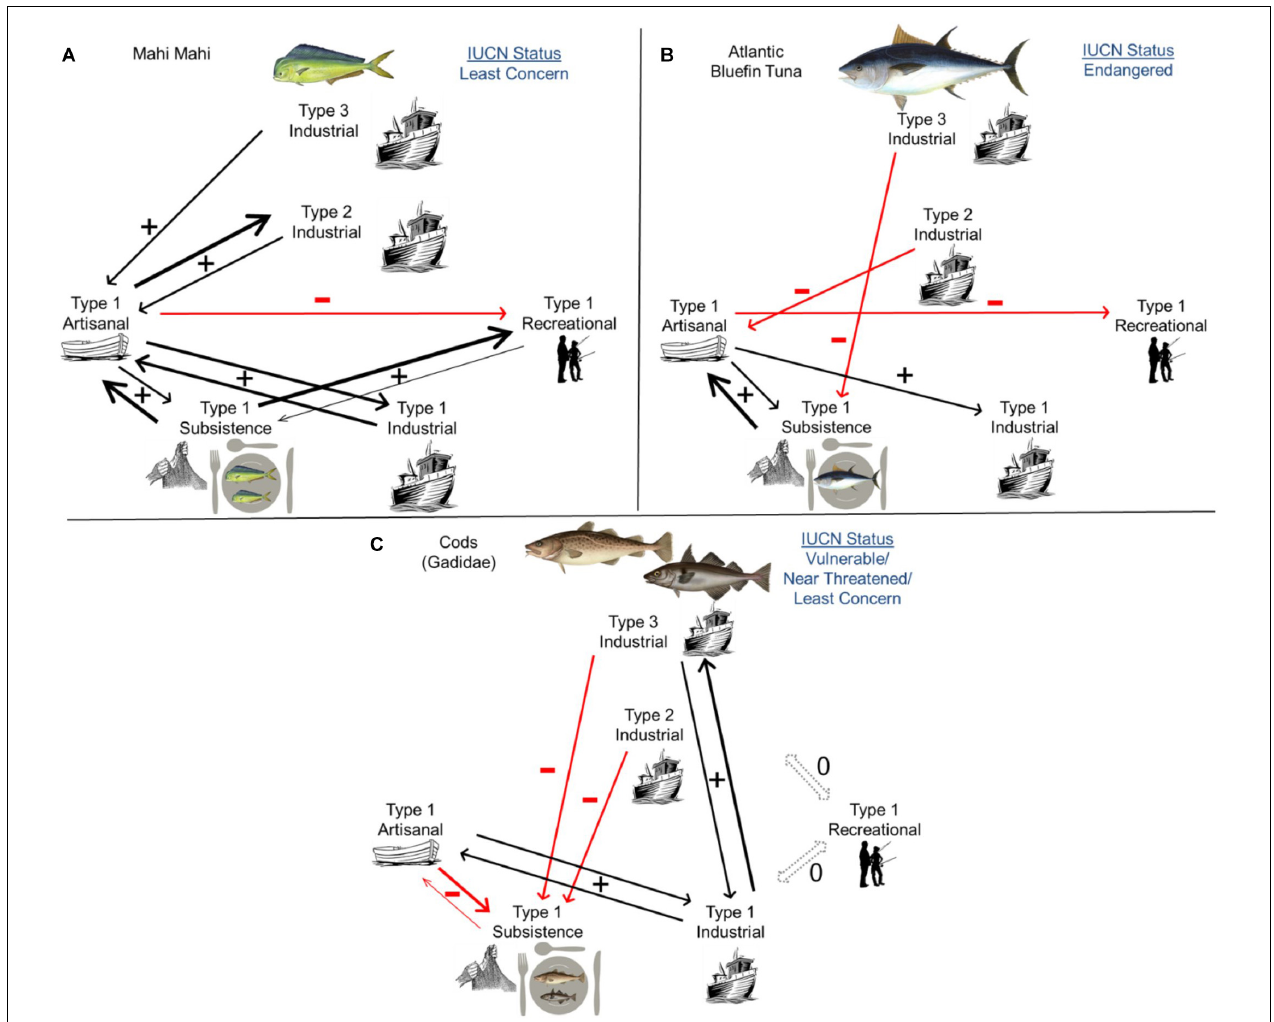
FIGURE 6 | Metacoupling relationships for (A) mahi-mahi, (B) Atlantic bluefin tuna, and (C) cods (family Gadidae). Fishing types are organized by spatial scale (Type 1, 2, 3) and sector (artisanal, subsistence, industrial, recreational). Positive interactions are depicted in black and negative interactions in red, with arrow width proportional to effect size ( Supplementary Tables 1–3 ). Statuses of each taxon on the International Union for Conservation of Nature (IUCN) Red List are also